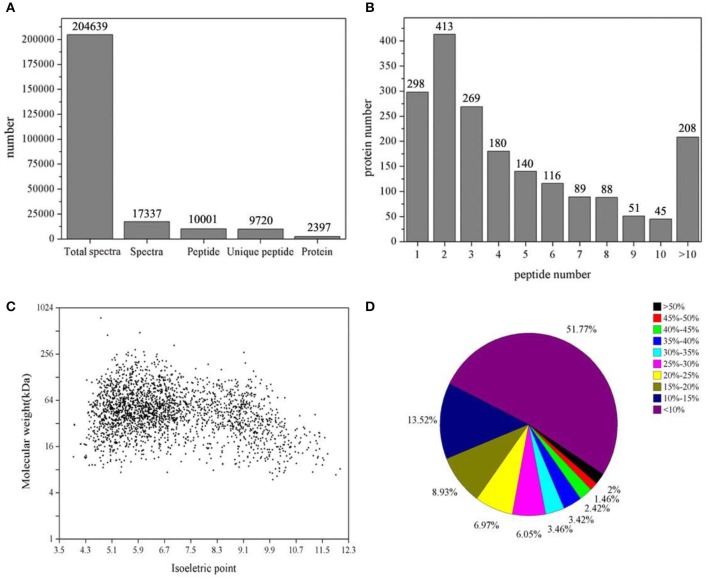
Summary of iTRAQ results. (A), total spectra, matched spectra, matched peptides, unique peptides, and identified proteins. (B), number of peptides associated with identified proteins. (C), molecular weights vs. isoelectric points, as calculated from protein sequences. (D), sequence coverage for identified proteins.